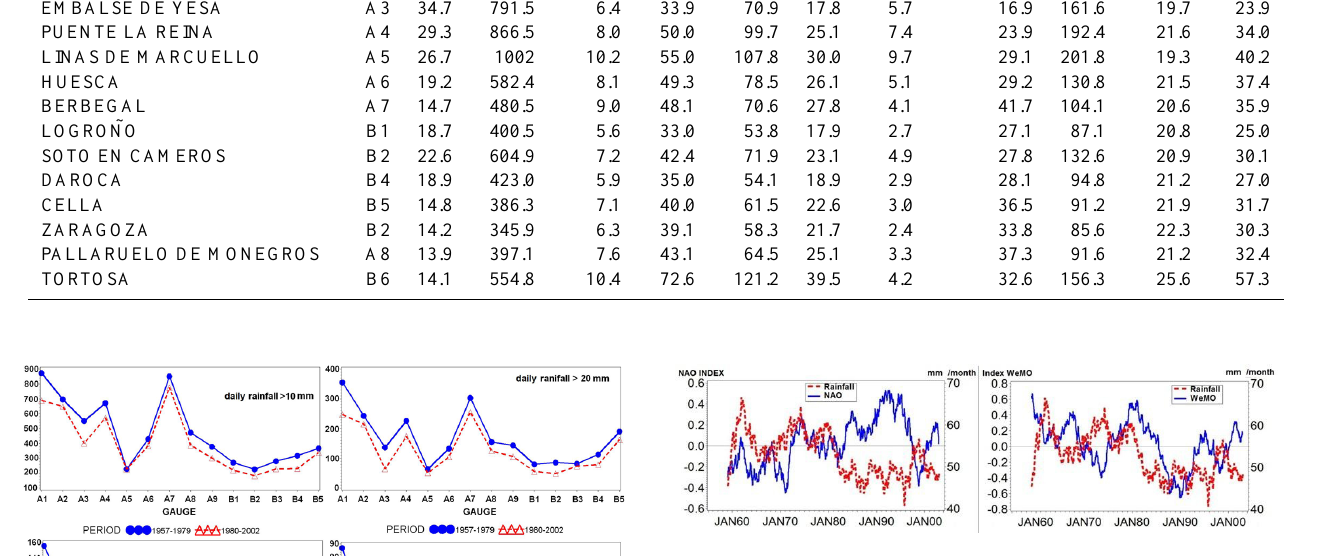
Fig. 3. Mean month rainfall in our 14 gauges of Ebro River Basin and NAO index (a) and WeMO Index (b) . Series are smoothed of the last 36